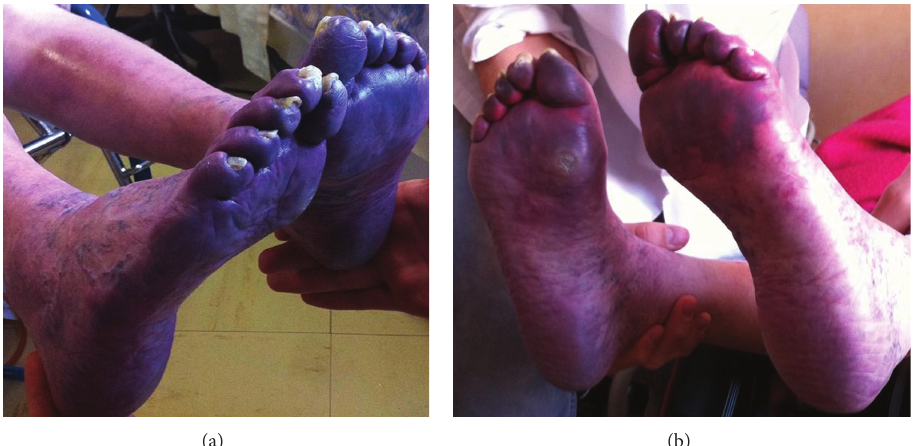
Figure 1: (a) Photograph of the soles on day 13 of hospitalization. (b) Photograph of the soles on day 19 of